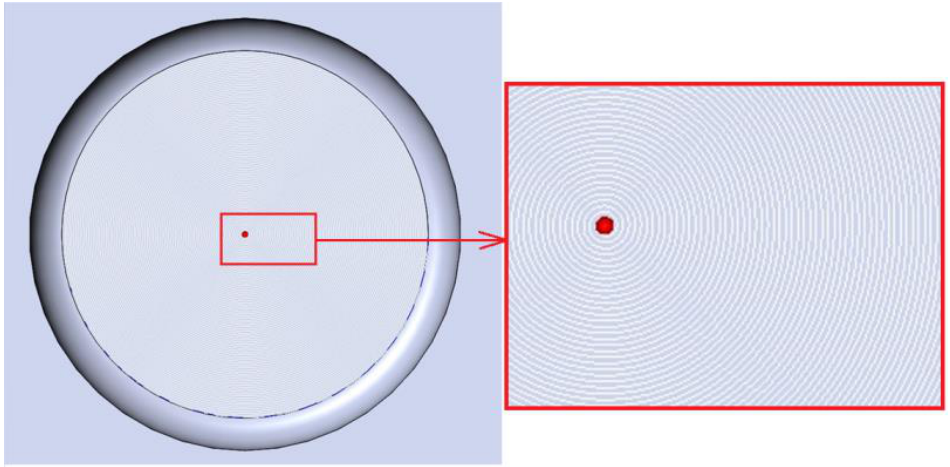
Figure 5. The schematic diagram of the spiral strategy.